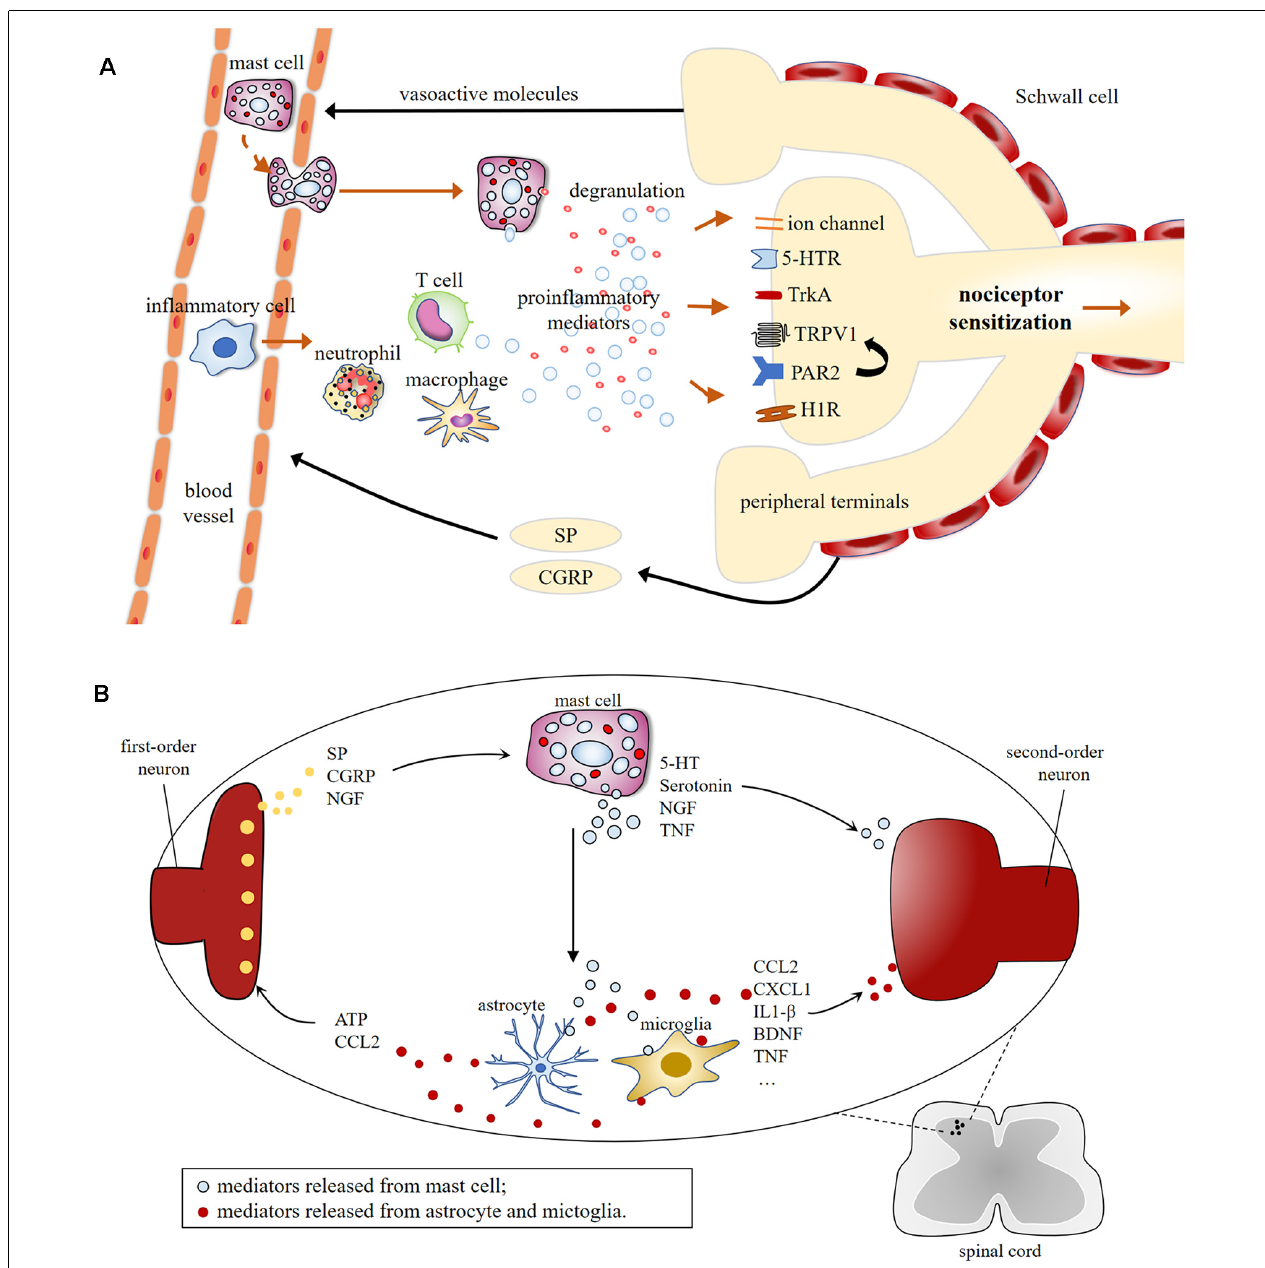
FIGURE 2 | (A) Schematic illustration of mast cell involvement in peripheral sensitization in the terminals of nociceptive primary afferents. Mast cell degranulation induces the production of proinflammatory mediators [e.g., 5-HT, TNF, nerve growth factor (NGF), histamine, tryptase], resulting in nociceptive neurons release vasoactive neuropeptides, which in turn, leads to the recruitment of immune cells, including mast cells, macrophage, neutrophil, T cell, etc. This leads to the possibility of positive feedback loop, which could lead to chronic pain. (B) Molecular mechanisms of central sensitization induced by mast cells degranulation in first-order excitatory synapses, where communications between neuronal and non-neuronal cells occur. Central terminals of nociceptors release inflammatory factors that activate the second-order neurons and non-neuronal cells including mast cells, which induces neuronal activation via producing proinflammatory cytokines and chemokines [e.g., TNF, interleukins (IL)-1 β , CCL2, CXCL1], and granular components, such as 5-HT and